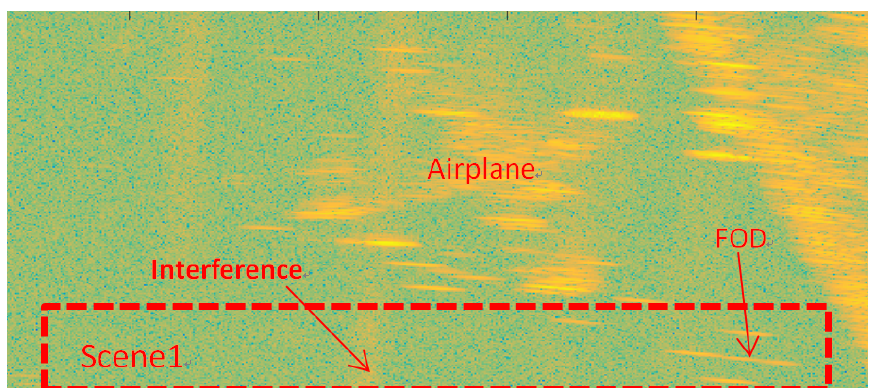
Figure 8. FOD targets deployment in Scene 1.